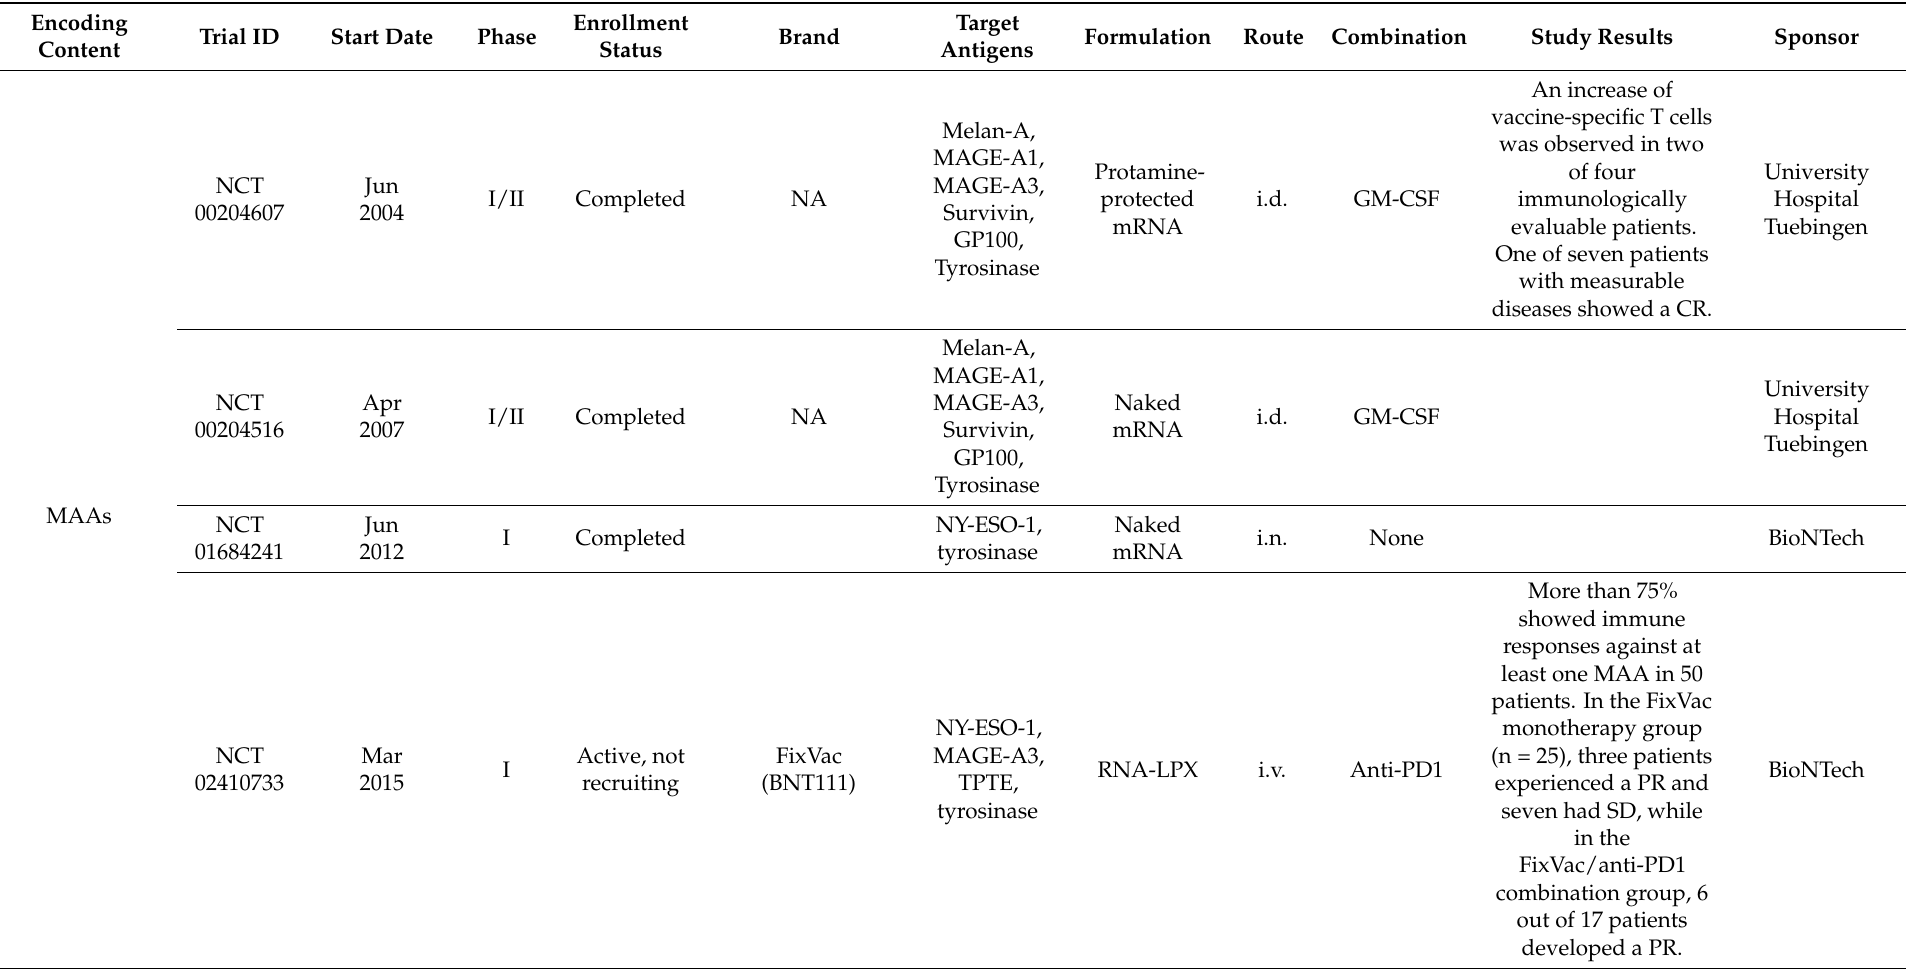
Table 1. Clinical trials of IVT mRNA-based vaccines for the treatment of